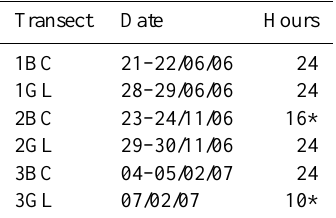
Table 1. Transects in the Bay of C´adiz (BC) and the Guadalquivir estuary (GL), date when transects were done and hours of the tidal cycle covered. In some cases (*), due to bad weather conditions, the 24h cycle could not be completed.